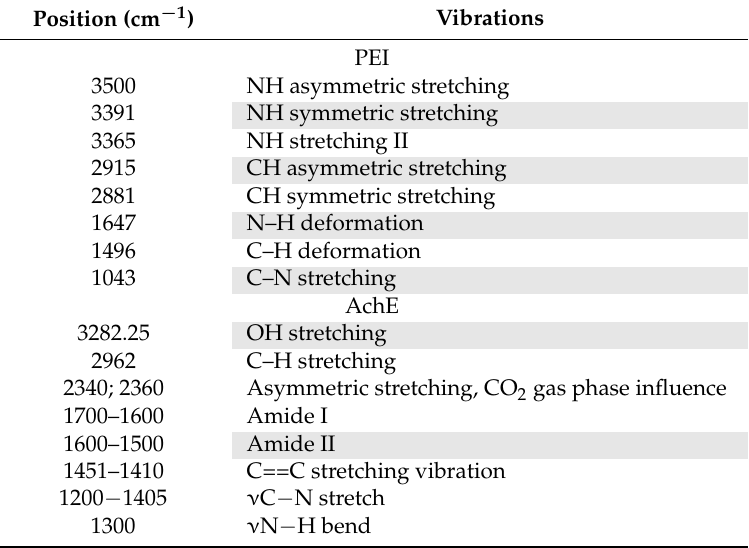
Table 1. Fourier transform infrared (FTIR)